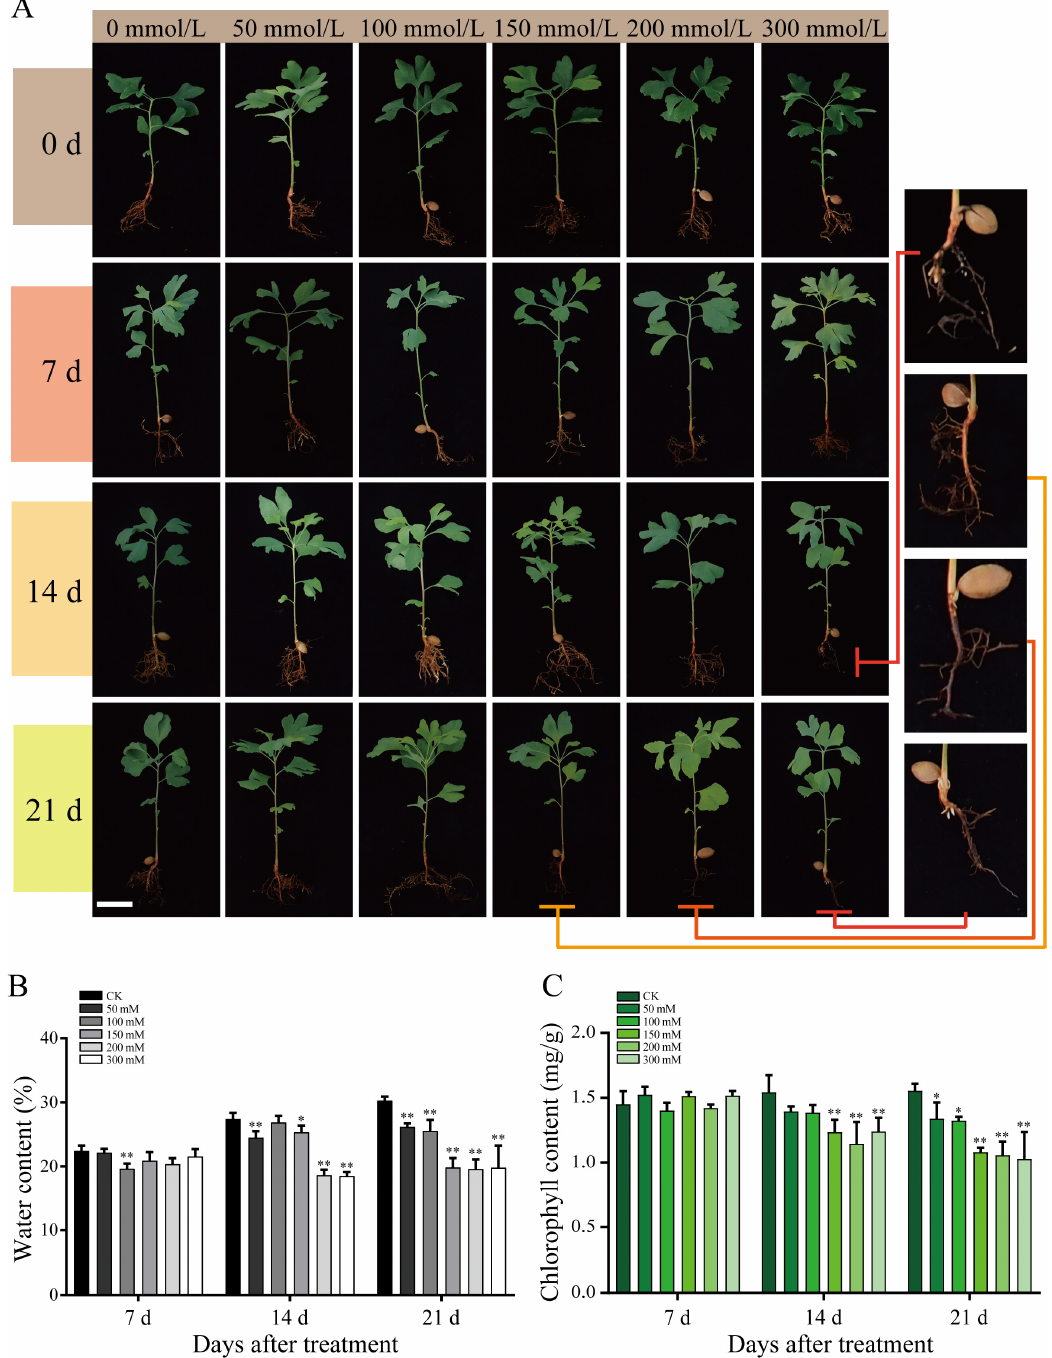
Figure 1. Growth of G. biloba seedlings. ( A ) Growth of G. biloba seedlings under 0, 50, 100, 150, 200, and 300 mmol / L NaCl concentrations harvested on days 0, 7, 14, and 21. The right insert shows an enlarged view of the roots treated with high NaCl concentrations. ( B ) Percentage water content of G. biloba seedlings. The vertical bars indicate standard deviation (SD; n = 16). ( C ) Total chlorophyll content of G. biloba seedlings. * p < 0.05; ** p < 0.01. The vertical bars indicate SD ( n = 9).